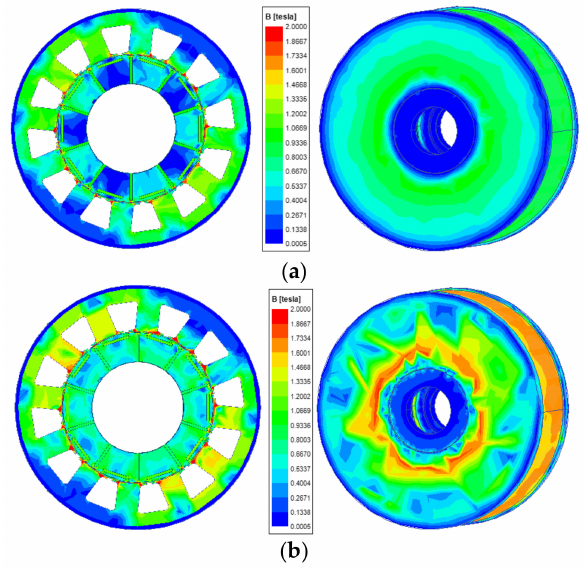
Figure 11. Flux density nephogram at no-load condition. ( a ) i f = 0 A; ( b ) i f = 4 A.